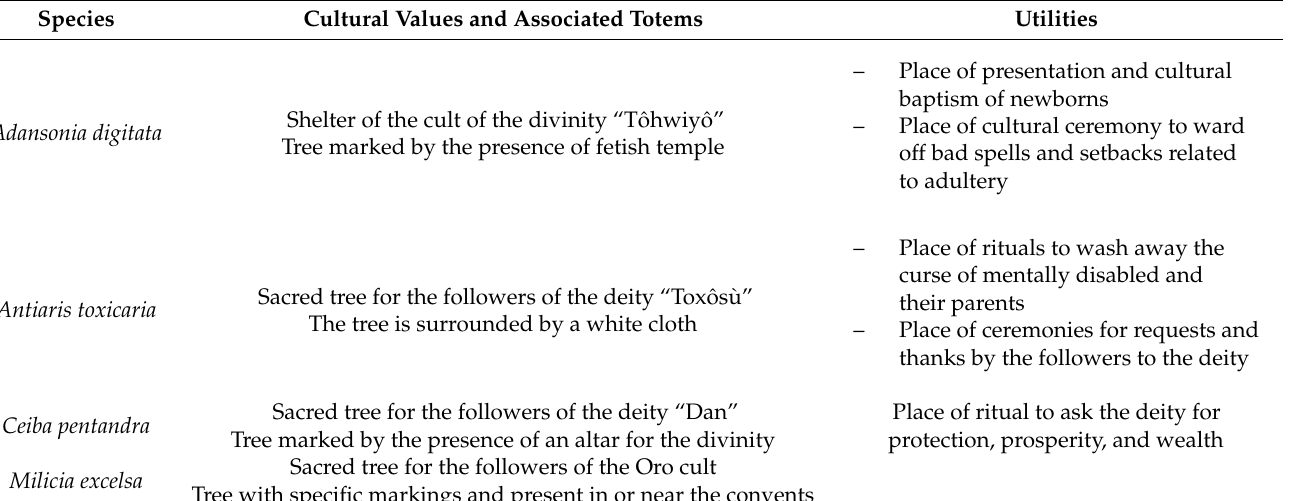
Table 9. Description of the cultural values (local conservation method) leading to sacralization of some